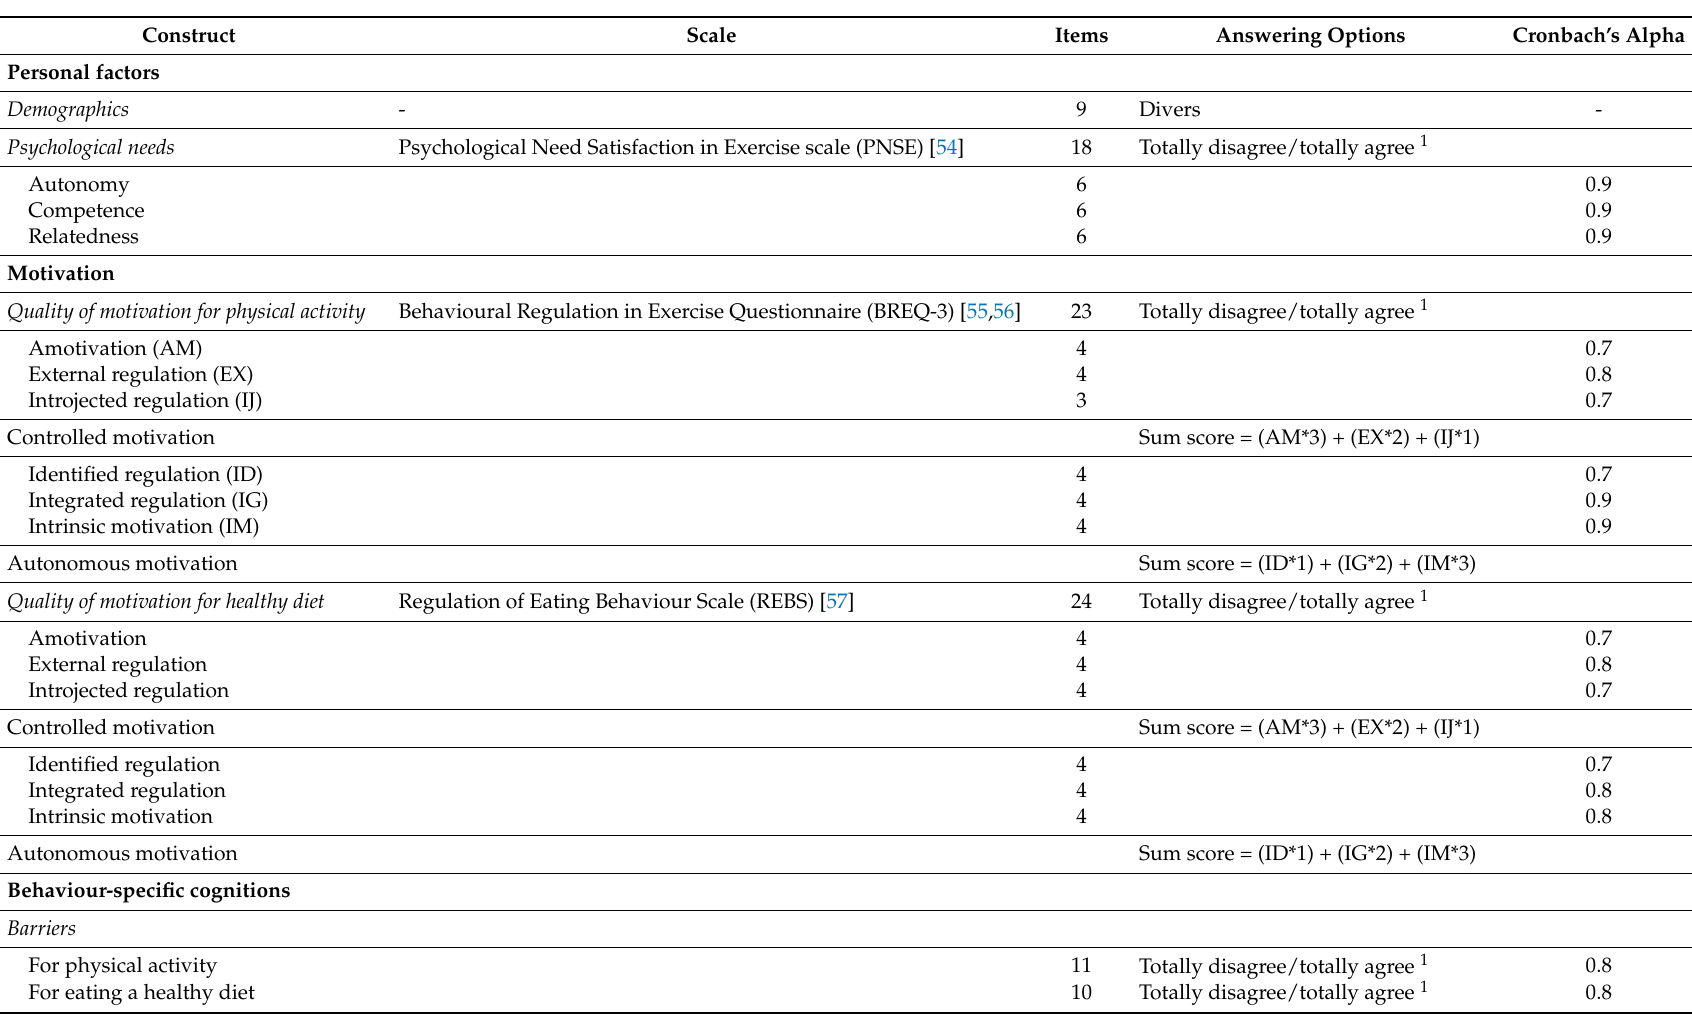
Table A2. Constructs used in the questionnaires for the adult participants, with their corresponding